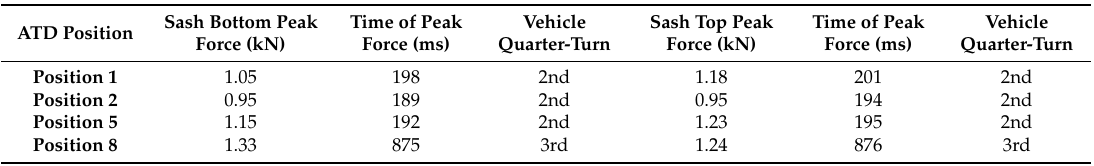
Table 14. Peak sash belt axial